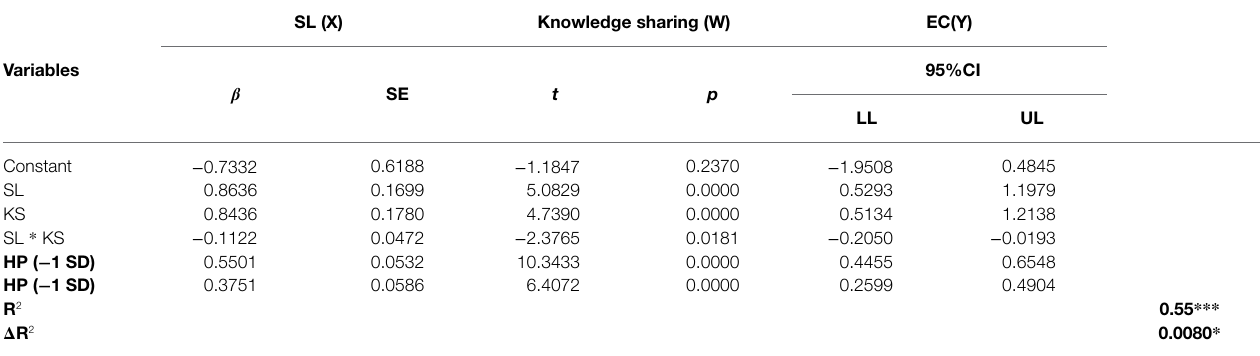
TABLE 6 | Moderation analysis.